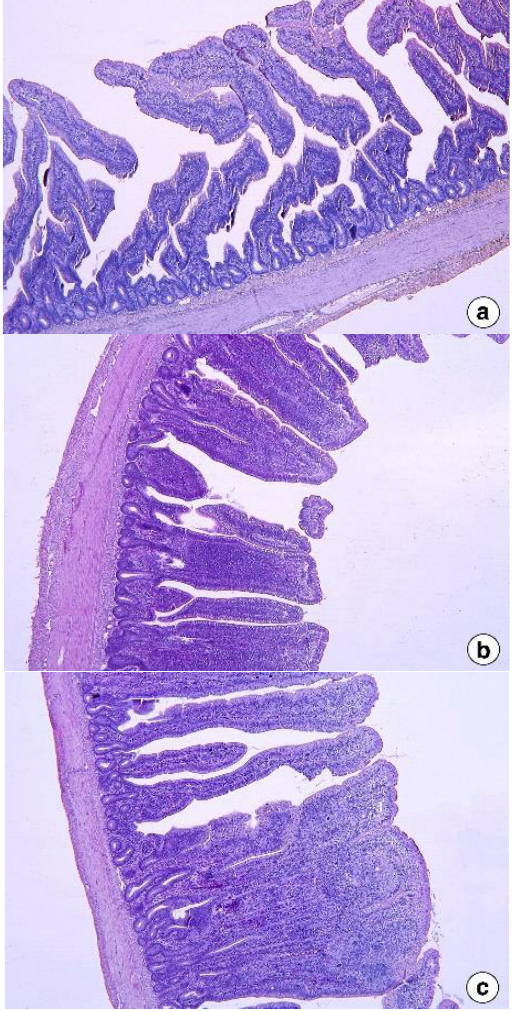
Figure 2. Histomorphology of the ileum of broilers at 42 days of age from the control group ( a ), FS5 group ( b ), and FS10 group ( c ) (H & E stain, × 50